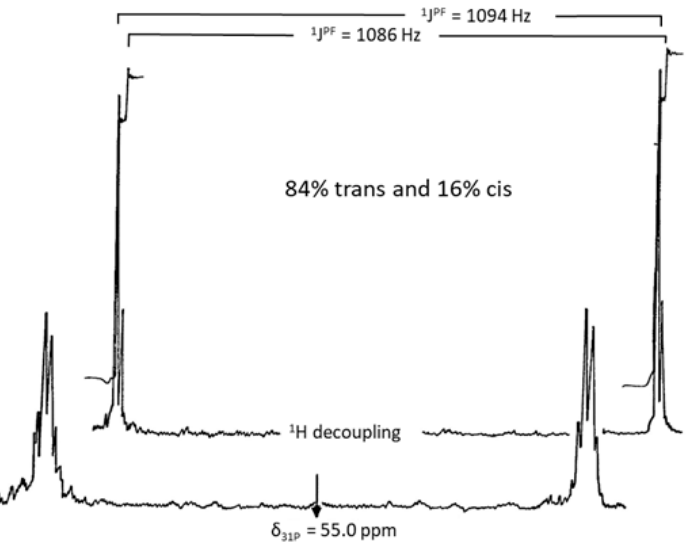
Figure 5. 31 P-NMR spectra of trans - 6 ( F ) (85%) and cis - 6 ( F ) (15%) mixture: upper spectrum with a proton decoupling, bottom spectrum without proton decoupling.